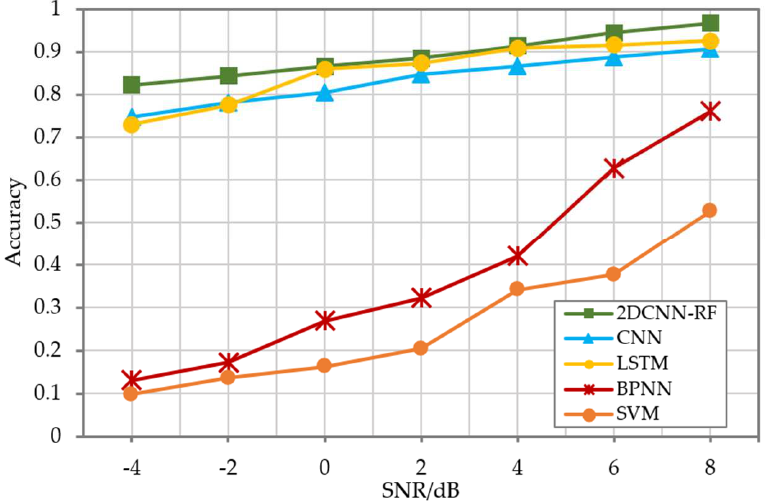
Figure 13. Performance comparison under different noise conditions.